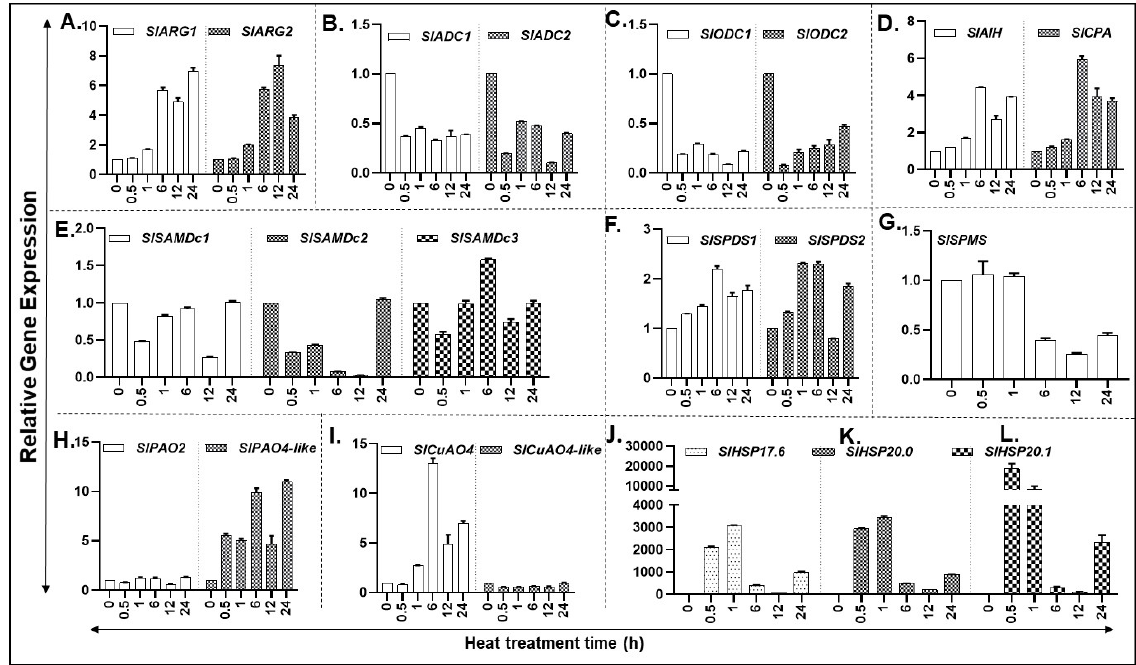
Figure 3. Heat-induced expression of PA metabolic pathway encoding genes in tomato plants exposed to 42°C temperature. A., B., C., D. qRT-PCR based relative gene expression analysis of tomato leaf tissue reveals differential abundance of putrescine (PUT) biosynthesis genes ( SlARG1, 2 , SlADC1, 2 SlODC1, 2, SlAIH and SlCPA ); E., F., G. Spermidine (SPD) and Spermine (SPM) biosynthesis genes ( SlSAMDc1, 2, 3, SlSPDS1, 2 and SlSPMS ); H. and I. PA catabolic pathway genes ( SlPAO2 and SlPAO4-Like; SlCuAO and SlCuAO4-like ); J., K., L. Heat shock protein genes HSP17.6, 20.0 and 20.1. A minimum of three leaves were excised from three plants for each biological replicate. Mean data points and standard error of a minimum of three biological replicates are shown. Statistical significance (p-value) was derived using Graph prism pad program via Tukey test/t-test. SlUBI3 and SlTIP41 were used as reference genes.